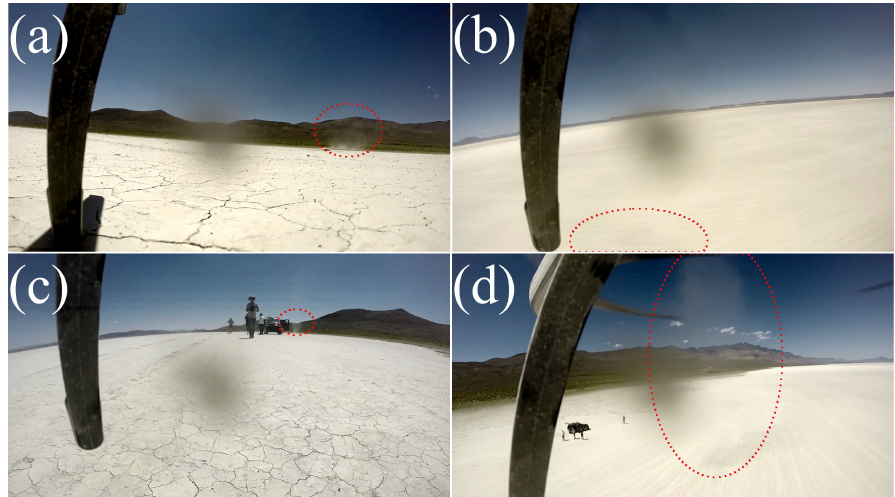
Figure 4. Stills from the video collected onboard the drone during Flight 2. ( a ) just prior to launch (which occurred at approximately timestamp 0:14), with the first target dust devil highlighted by a red, dashed circle; ( b ) the dust skirt of the first target dust devil just prior to one encounter, which occurred approximately 22 s after launch (at timestamp 0:36); ( c ) the drone has nearly landed after encountering the first dust devil seen during Flight 2, but instead of landing, the drone ascended again to chase the dust devil highlighted to the right of the pilot; ( d ) just prior to the first encounter with the second dust devil seen during Flight 2 about 2 min after launch (timestamp